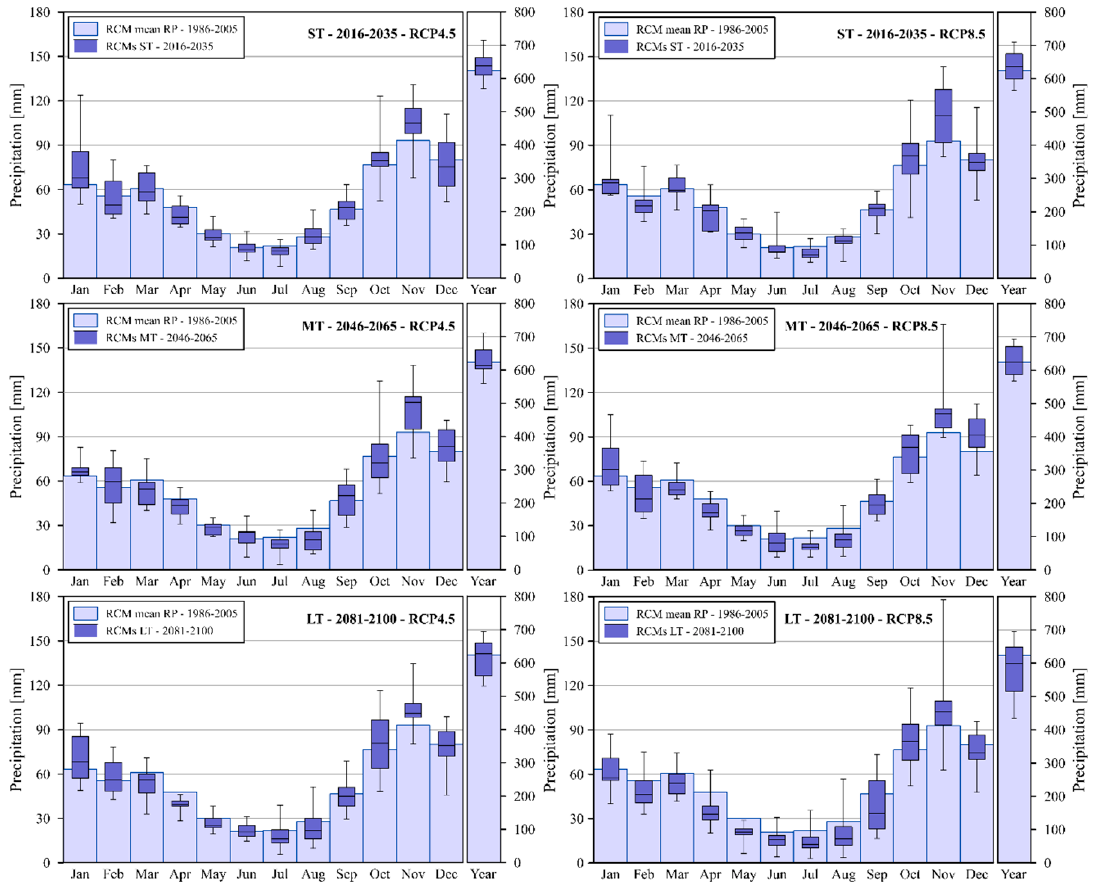
Figure 7. Monthly and annual precipitation, over the Salento area, evaluated by the RCMs at the short—(ST), medium—(MT) and long-term (LT) under the RCP4.5 and RCP8.5 scenarios. The box-whisker plots represent the variability between the 13 RCMs (the whiskers indicate the minimum and maximum values). Bars of the RCM ensemble mean in the reference period (RP).